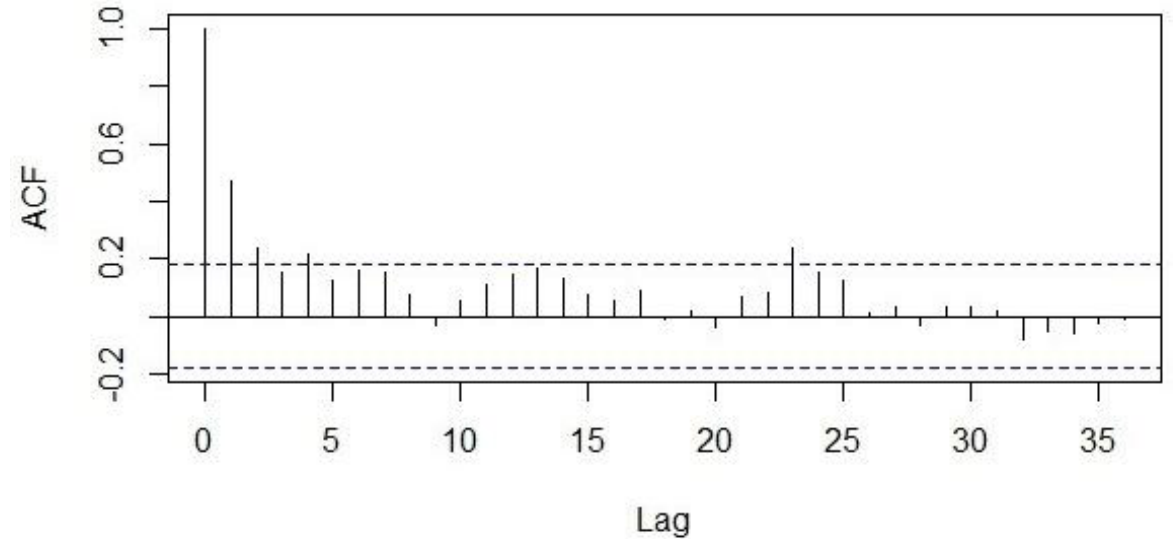
Fig. 5. The autocorrelation chart of the ARIMA